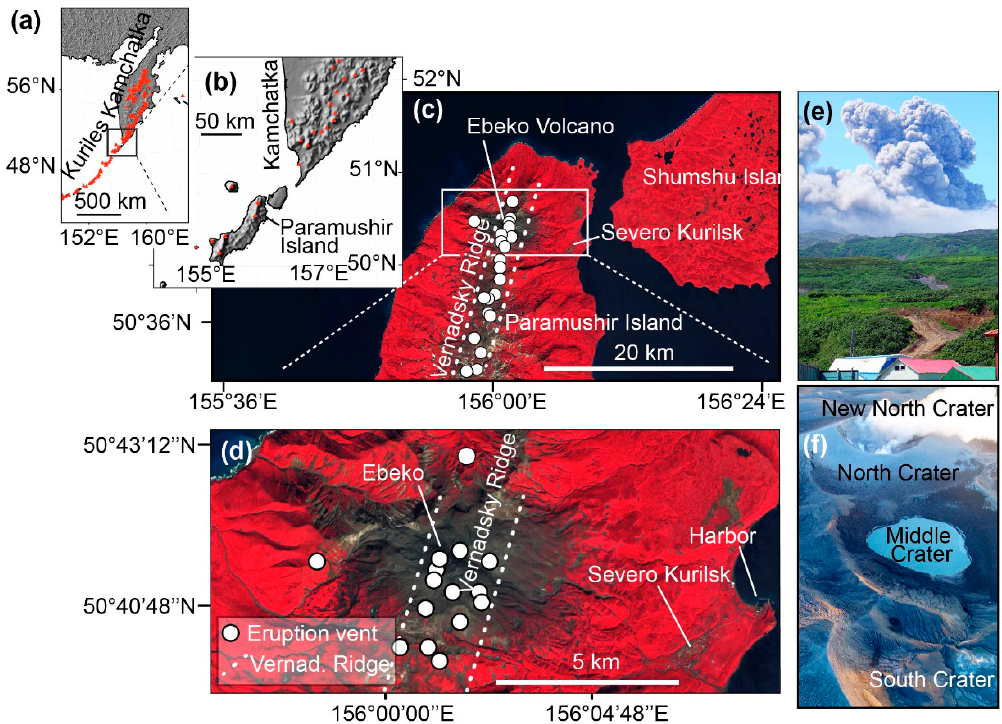
Figure 1. ( a ) Location map in northern Kuriles. ( b ) Southern Kamchatka and Paramushir Island, with Ebeko volcano being the northernmost volcano on the island. ( c ) Satellite color infrared (Sentinel-2 bands 8,4,3 from 13 September 2017) showing vegetation in red and bare soils and volcanic deposits in gray. The Vernadsky Ridge (white dotted line) is defined by fissures and cone alignments (relevant cones and crater vents are indicated by white circle symbology). ( d ) Close-up of Ebeko volcano, with a distance to the town of Severo-Kurilsk of only 7 km. ( e ) Eruption at Ebeko as seen from Severo-Kurilsk on 11 July 2019 and ( f ) UAS view on 14 July 2019 showing the three craters aligned NNE-SSW, with the current eruptions in the New North Crater, a cold lake in the Middle Crater and fumaroles in the South Crater.